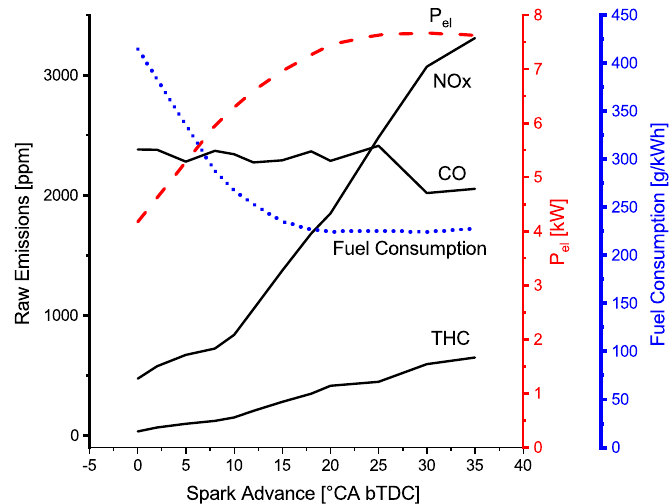
Figure 2. Raw pollutant emissions, electrical power and fuel consumption as a function of the spark advance (equivalence air/fuel ratio λ =